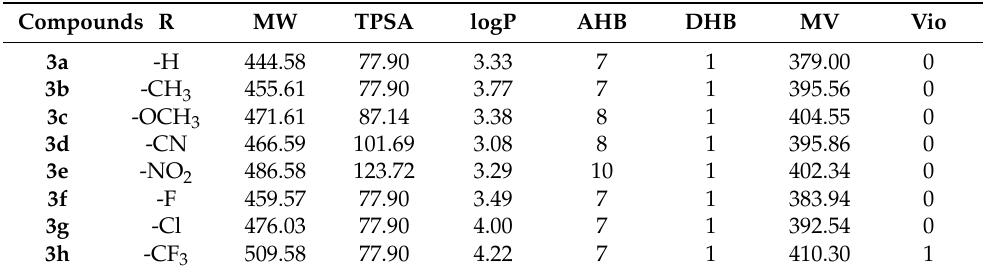
Table 1. Some physicochemical parameters of the compounds 3a – 3h used in the prediction of